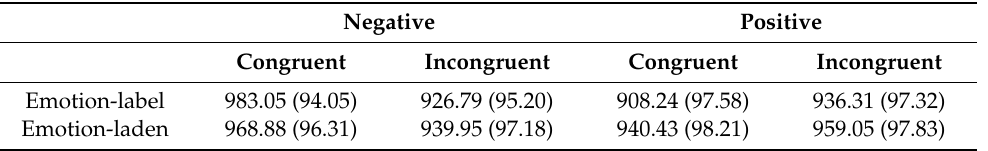
Table 3. Mean reaction time (ms) and accuracy rate (%) in brackets of emotion-label words and emotion-laden words as a function of congruency and valence (Experiment